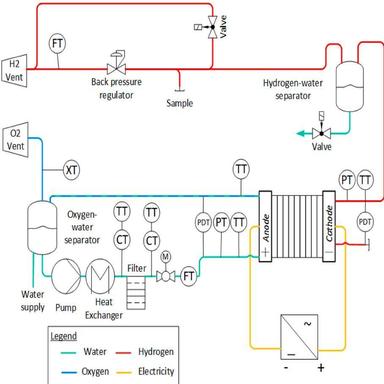
Schematic illustration of the stack testbench (Abbreviations are listed in section 5).